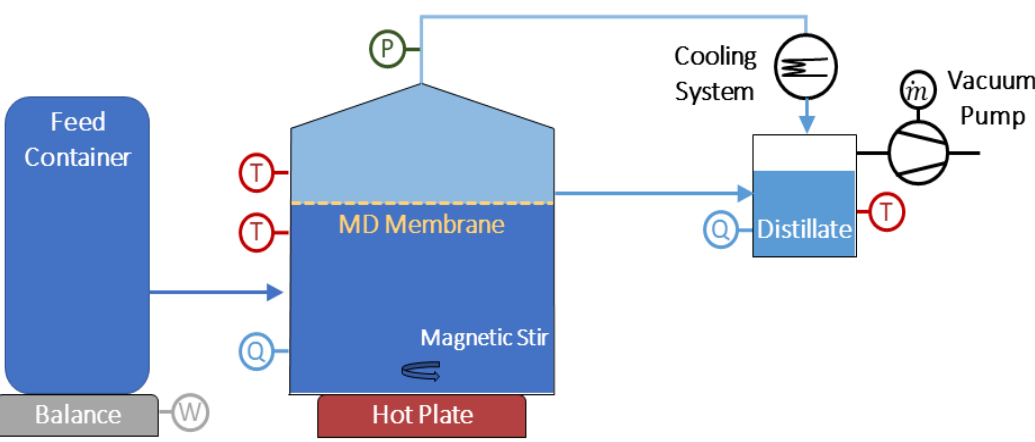
Figure 1. Vacuum membrane distillation (VMD) process schematic. The setup consisted of a feed container, a stirred membrane cell, a distillate collection vessel, a feed container, a magnetic stirrer, an external condenser, a balance, and a vacuum pump.